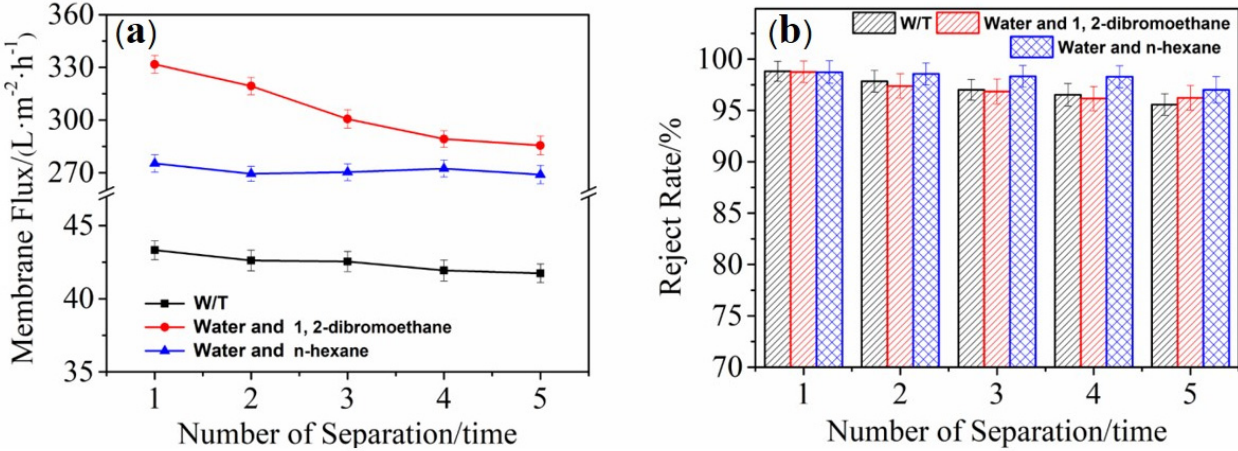
Figure 17. ( a ) Variation curve of the membrane flux of Janus–CA fiber membranes with the number of separations. ( b ) The interception rate of Janus–CA fiber membranes with the number of separations.